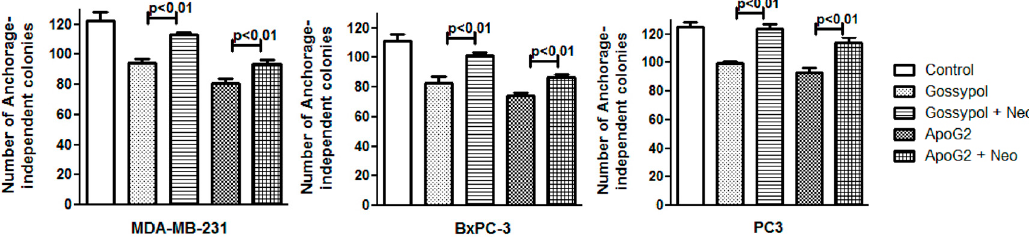
Figure 4. Cancer cell lines were plated in 24-well plates as described in the Methods. Culture was supplemented with 5 μ M gossypol/ApoG2 with or without metal chelator neocuproine (Neo, 50 μ M). Colonies (>50 cells), after appropriate culture time (22 days), were counted. Experiments were done in quadruplicate and mean values are reported. p < 0.01 when compared to untreated control cells.